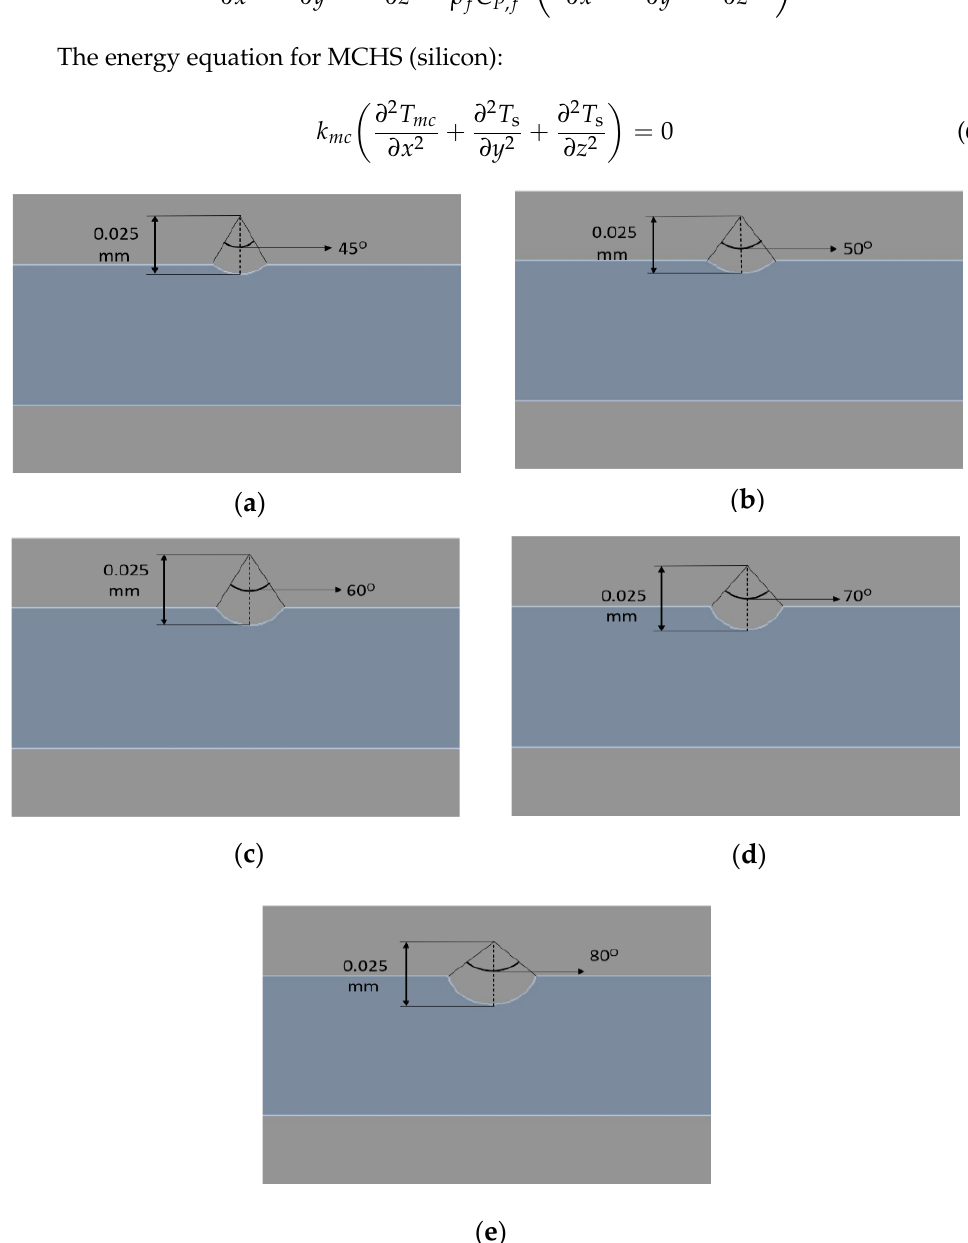
Figure 2. Cylindrical rib on the passage wall of the microchannel (top view) of angle ( a ) 45°, ( b ) 50°, ( c ) 60°, ( d ) 70°, and ( e ) 80°.